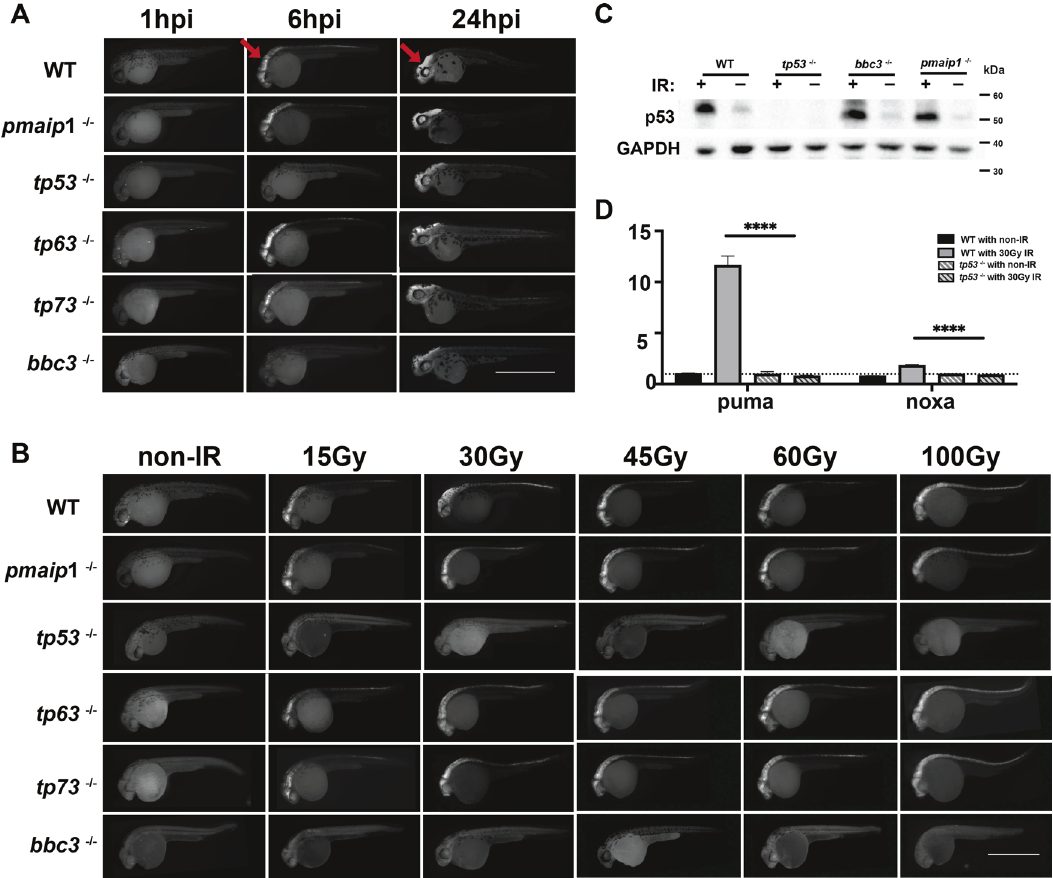
Fig. 3 Loss of puma not noxa rescues IR-induced apoptosis in p53-dependent manner. A Anti-active Caspase-3 staining on 30 hpf (1 hpi and 6 hpi panel) or 48 hpf (24 hpi panel) embryos. 29 hpf wild-type, pmaip1 − / − , tp53 − / − , tp63 − / − , tp73 − / − and bbc3 − / − zebra fi sh embryos were treated with 30 Gy IR-irradiation and fi xed at 1 hour post treatment (1 hpi panel); 24 hpf embryos were treated with 30 Gy IR-irradiation and fi xed at 6 h (6 hpi panel) or 24 h (24 hpi panel) after treatment. Arrows in WT points out active apoptotic area in head region in WT embryos for 6 hpi and 24 hpi. Scale bar, 1000 μ M. B Anti-active Caspase-3 staining of 30 hpf (6 hpi) wild-type, pmaip1 − / − , tp53 − / − , tp63 − / − , tp73 − / − , and bbc3 − / − zebra fi sh embryos treated w/o IR (non-IR) and with 15, 30, 45, 60, and 100 Gy IR. Scale bar, 1000 μ M. C p53 protein expression level after IR-induction. Western blot analysis was performed using protein extracts from 30 hpf (6 hpi) wild type, tp53 − / − , bbc3 − / − , and pmaip1 − / − zebra fi sh embryos with (30 Gy) or without IR treatment. D qRT-PCR analysis of puma and noxa after IR-irradiation in zebra fi sh embryos. 24 hpf wild-type or tp53 − / − zebra fi sh embryos were treated with 30 Gy IR-irradiation and RNA samples for qRT-PCR were harvested at 6 h after IR-irradiation. Expression levels were normalized to GAPDH. n = 6 from ~30 pooled embryos per sample. Bars represent mean ± SEM. **** p <